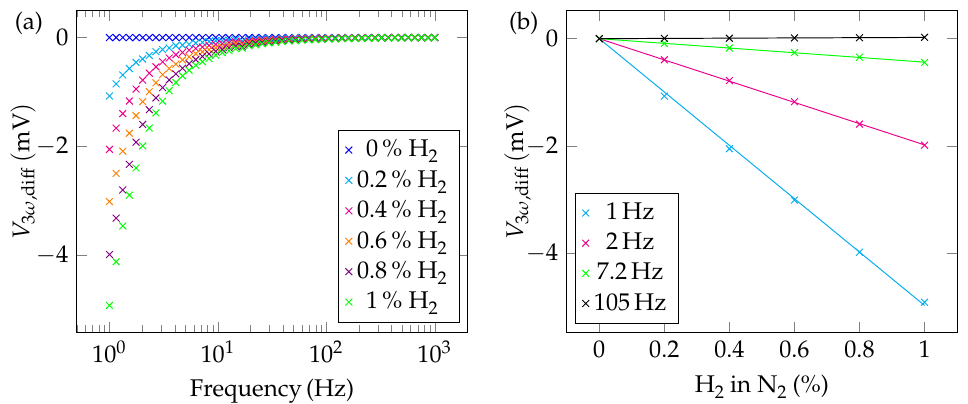
= 0%H = 0%H 2 ) as a 2 ) as a b (cid:98)